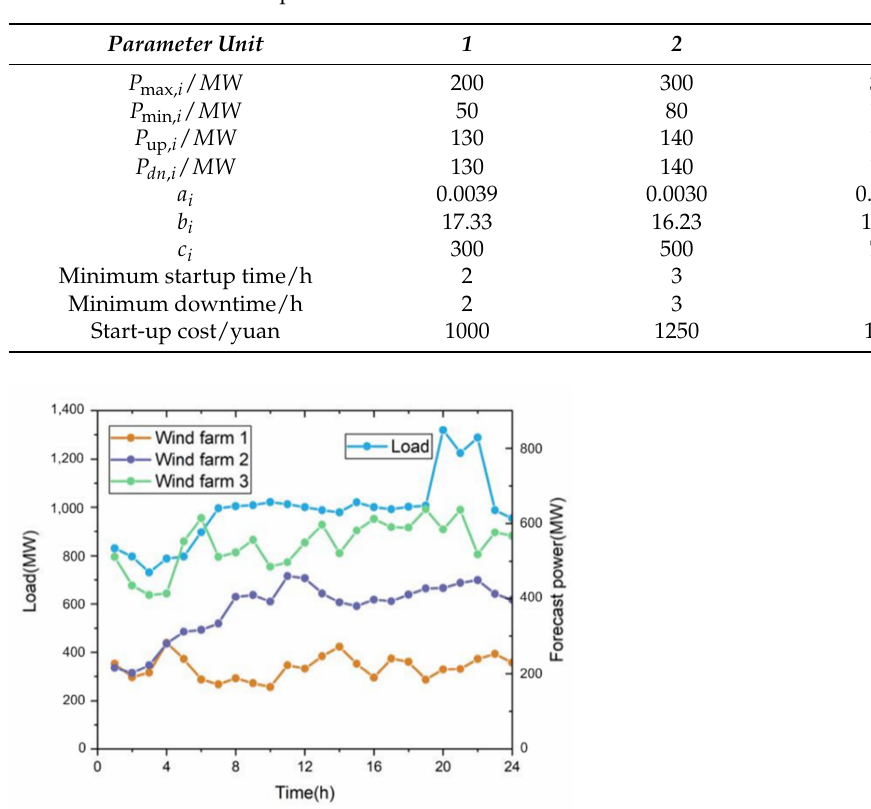
Table 4. Conventional unit parameters.